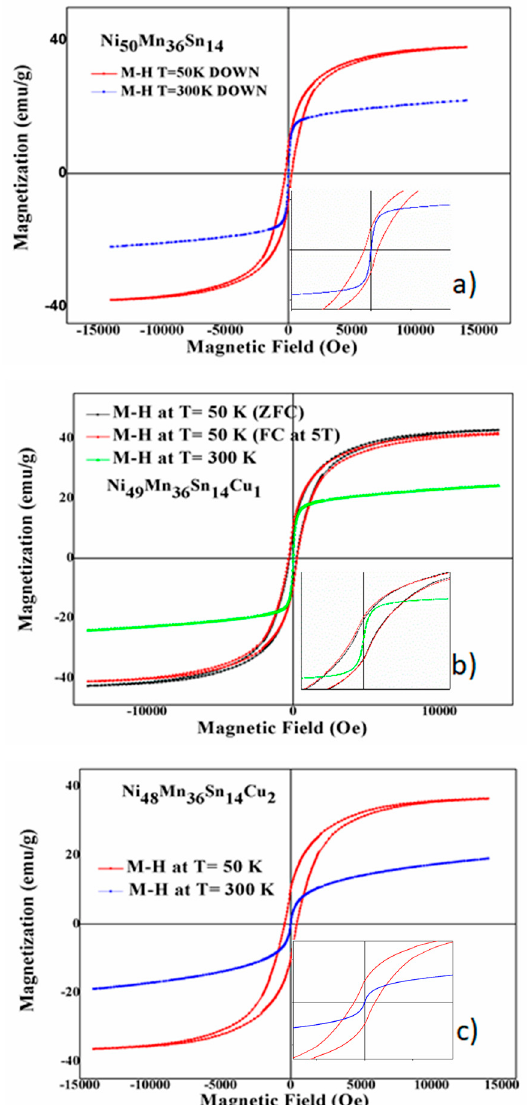
Figure 8. Magnetic hysteresis loops at room temperature of alloys: ( a ) Ni 50 Mn 36 Sn 14 , ( b ) Ni 49 Mn 36 Sn 14 Cu a and ( c ) Ni 48 Mn 36 Sn 14 Cu 2 .